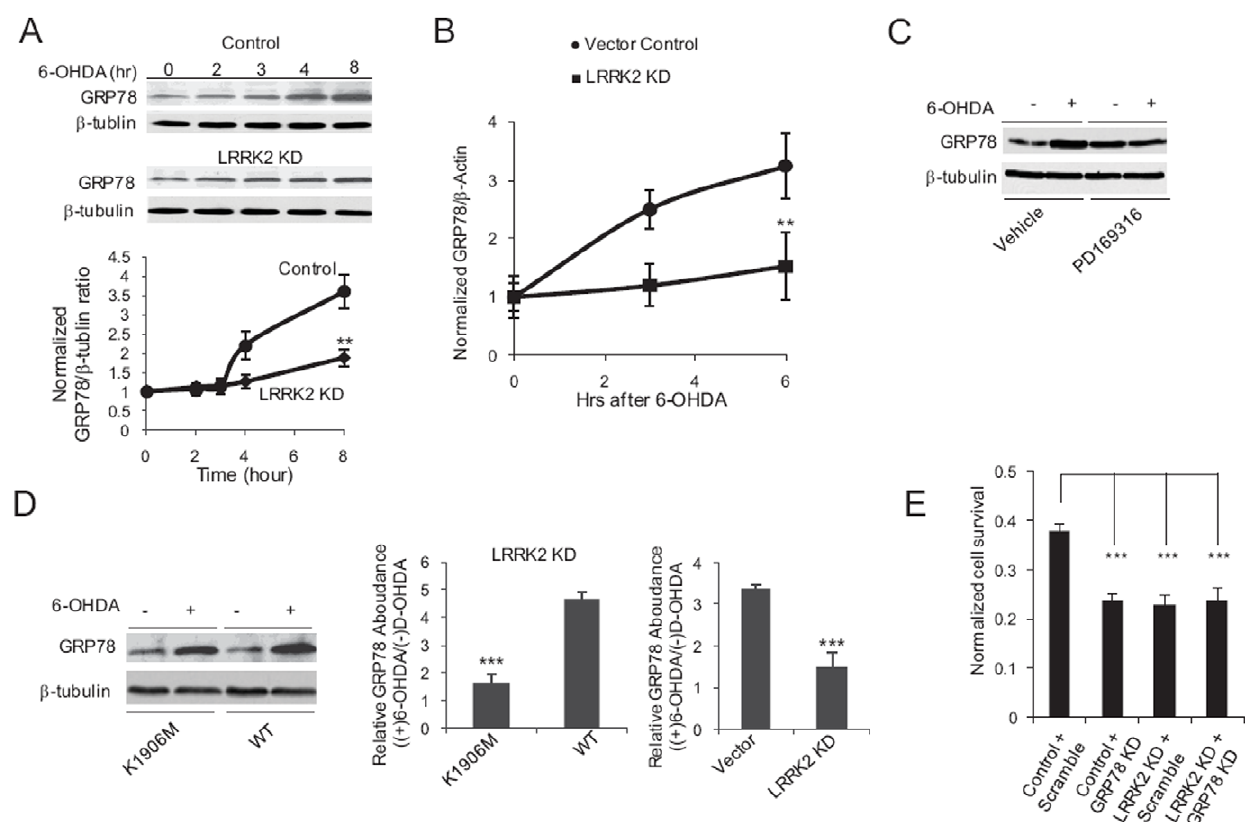
Figure 4. LRRK2 signaling modulates GRP78 levels to potentiate cell survival after 6-OHDA exposure. ( A ) LRRK2 is involved in 6-OHDA- mediated upregulation of GRP78 protein levels. Western blot analyses were performed on lysates from SH-SY5Y cells transfected with a control vector (Control, circles) and MIX LRRK2 KD SH-SY5Y cells (LRRK2 KD, diamonds) treated with 100 m M 6-OHDA for the indicated periods of time. Representative Western blots are shown, as well as quantization of results from 3 independent experiments. Data represent the mean 6 SEM of 3 independent experiments. **, p , 0.01 by two-way ANOVA. ( B ) Induction of GRP78 via 6-OHDA/LRRK2 occurs at the mRNA level. qRT-PCR quantification of GRP78 and b -actin (housekeeping control for normalization) mRNA levels was performed on SH-SY5Y cells transfected with a control vector (circles) and MIX LRRK2 KD SH-SY5Y cells (squares) treated with 100 m M 6-OHDA for the indicated periods of time. Data represent the mean 6 SEM of 3 independent experiments. **: p , 0.01 by two-way ANOVA. ( C ) Inhibition of p38 with PD169316 compromises 6-OHDA-induced upregulation of GRP78. Western blotting was performed on SH-SY5Y cells treated with 100 m M 6-OHDA together with 20 m M PD169316 or vehicle for 8 hours. ( D ) LRRK2 kinase activity contributes to induction of GRP78 by 6-OHDA. Western blotting was performed on 3 9 -UTR LRRK2 KD SH-SY5Y cells transfected with WT (WT) or K1906M mutant LRRK2 (K1906M) treated with 100 m M 6-OHDA for 8 hours. Left panel, sample blots. Middle panel, quantification of Western blot results. Right panel, under similar experimental conditions, MIX LRRK2 KD SH-SY5Y cells (LRRK2 KD) displayed compromised 6-OHDA- mediated induction of GRP78 as compared to SH-SY5Y cells transfected with control vector (vector). Data in the middle and right panels represent the mean 6 SEM of 3 independent experiments. ***, p , 0.005 by t-test. ( E ) shRNA-mediated double KD of GRP78 and LRRK2 displayed a similar 6- OHDA-indcuced cell death rate to that observed in single KD of either GRP78 or LRRK2. Cell survival was assessed using an XTT-based calorimetric assay in Vector control SH-SY5Y cells transfected with a scramble shRNA (Control + Scramble), or GRP78 shRNA (Control + GRP78 KD) and in MIX LRRK2 KD SH-SY5Y cells transfected with scramble shRNA (LRRK2 KD + Scramble), or GRP78 shRNA (LRRK2 KD + GRP78 KD). Cells were exposed to 100 m M 6- OHDA for 12 hours prior to assessment of cell survival. Data are shown normalized to the level of survival in cell cultures not treated with 6-OHDA and represent the mean 6 SEM of 3 independent experiments. ***, p , 0.005; one-way ANOVA.